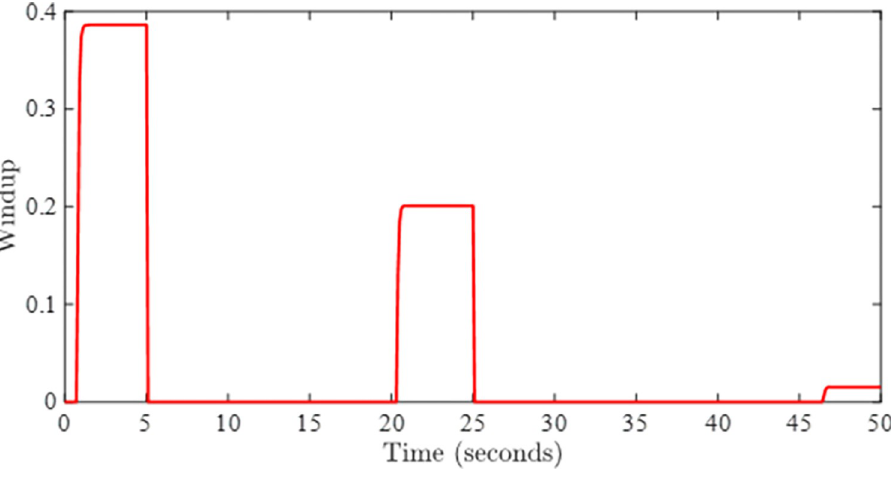
Fig 7. Windup effect with